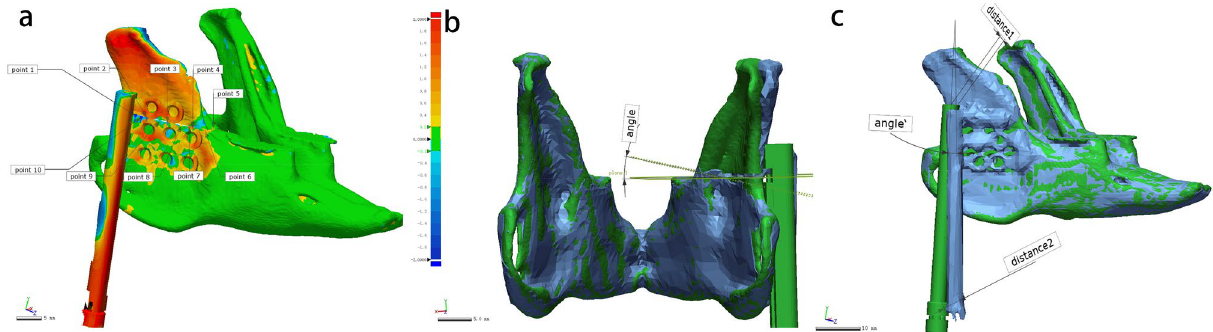
Figure 6. Accuracy analysis of osteotomy and distractor implantation. ( a ) Evaluation of the positional error according to ten points on the osteotomy plane. ( b ) Evaluation of the angular error according to the osteotomy planes. ( c ) Evaluation of the positional error according to the endpoints of the distractor’s driver screw, and evaluation of the distraction direction deviation using the lines through the